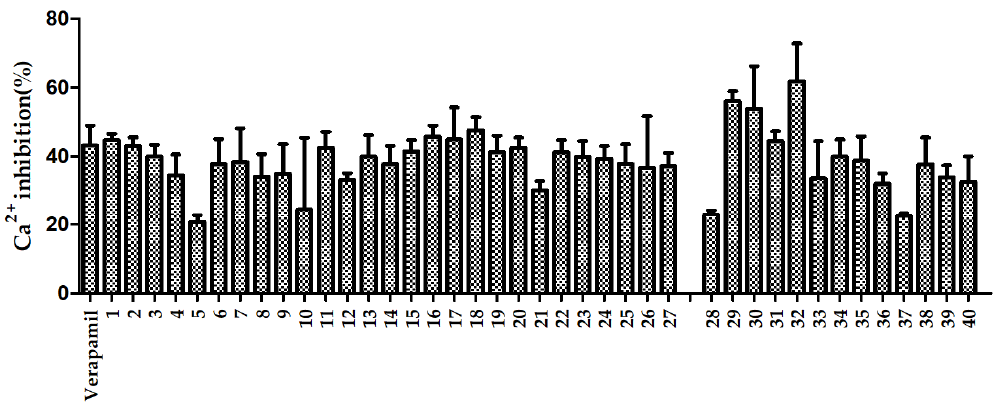
Figure 5. Ca 2 + inhibition rates of extracts of RAS from non-geoherbs (1–27) and geoherbs